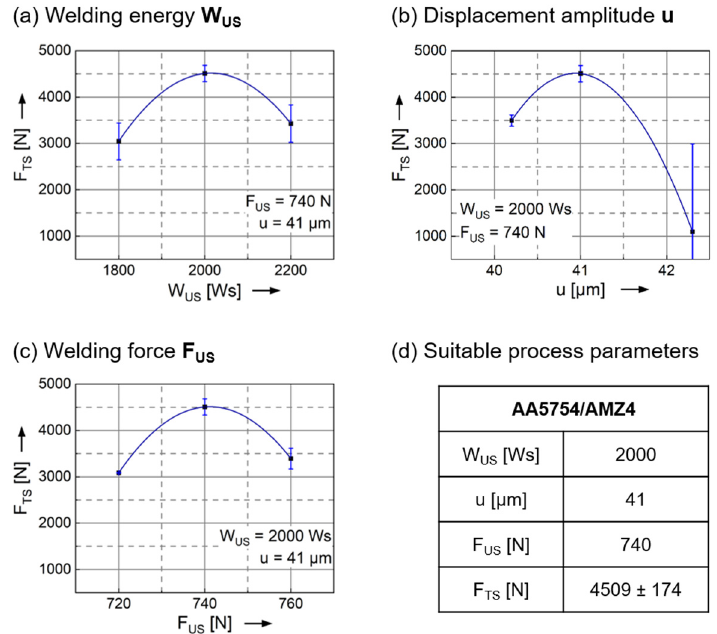
Figure 3. ( a ) Influence of the welding energy W US on the tensile shear force F TS , welding force and displacement amplitude are kept constant. ( b ) Influence of the displacement amplitude u on the tensile shear force F TS , welding energy and welding force are kept constant. ( c ) Influence of the welding force F US on the tensile shear force F TS , welding energy and displacement amplitude are kept constant. Each diagram is based on nine trials. ( d ) Suitable process parameters for AA5754/AMZ4 joints with the highest tensile shear forces and the best reproducibility.